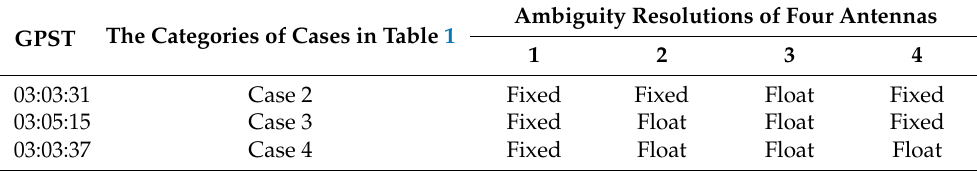
Table 3. The Ambiguity resolutions of four antennas in the selected three epochs.